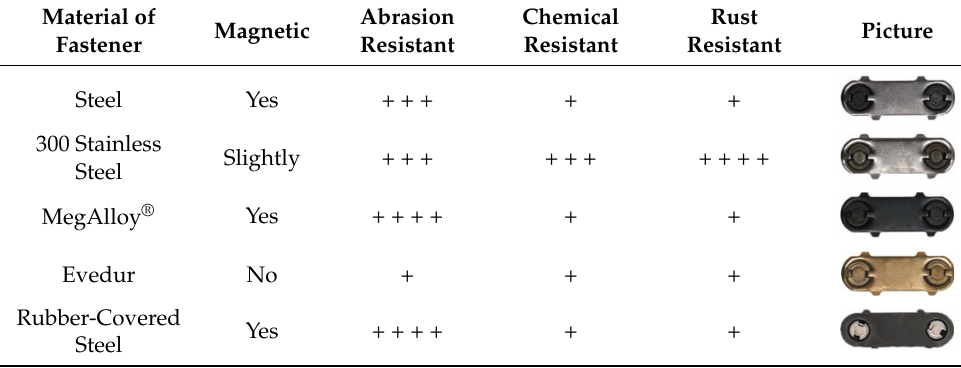
Rust Picture Resistant